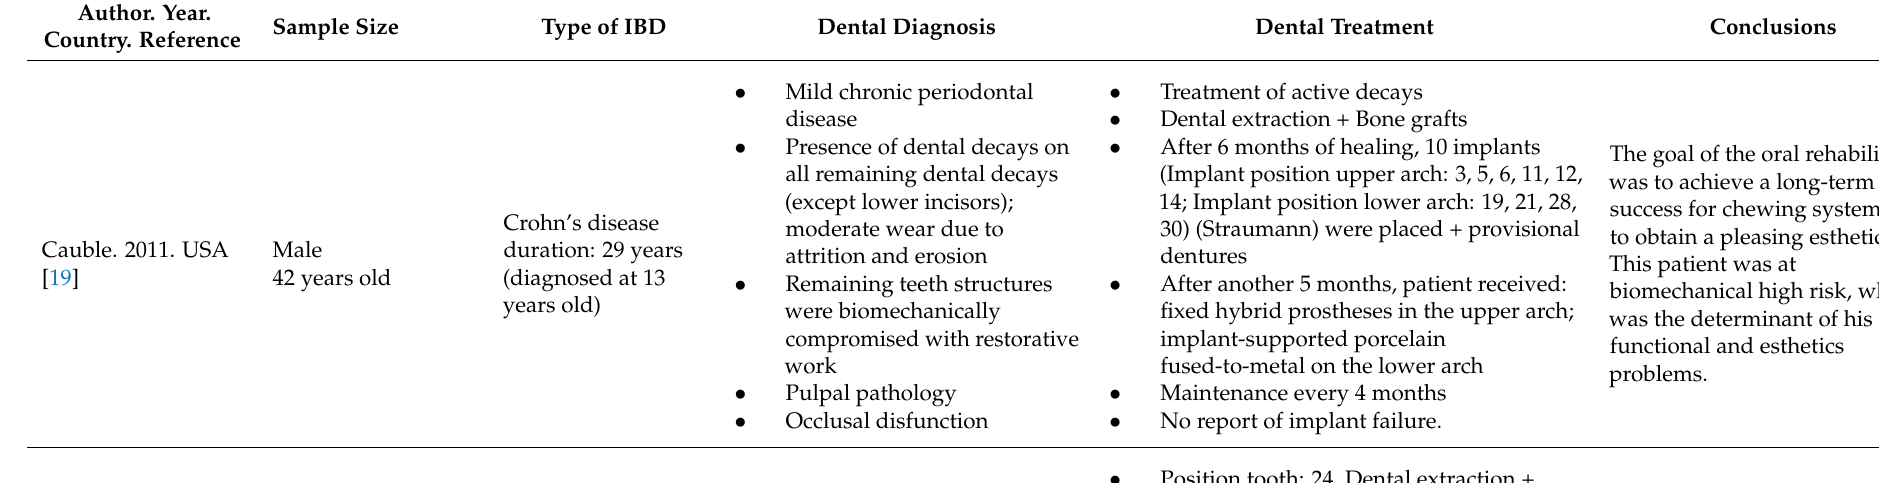
Table 2. Case reports relevant for clinical